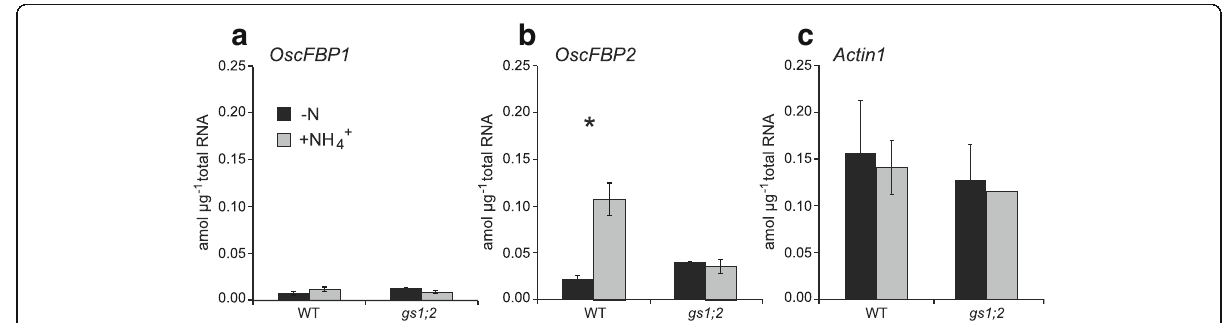
Fig. 5 Expression levels of OscFBPs in the basal portions of the shoots after NH 4+ supply. Transcript levels of OscFBP1 ( a ), OscFBP2 ( b ), and the control Actin1 ( c ) in the basal portions of the shoots of wild-type plants (WT: black column) and gs1;2 mutants ( gs1;2 : gray column) at the seventh leaf stage. Seedlings were grown in water for 3 d then treated either with (+NH 4+ ) or without (-N) 1 mM NH 4 Cl for 8 h. Mean values with SE for four independent plants are shown. Asterisks denote statistically significant differences between untreated samples and those treated with 1 mM NH 4 Cl (*, P < 0.05 by Student ’ s t